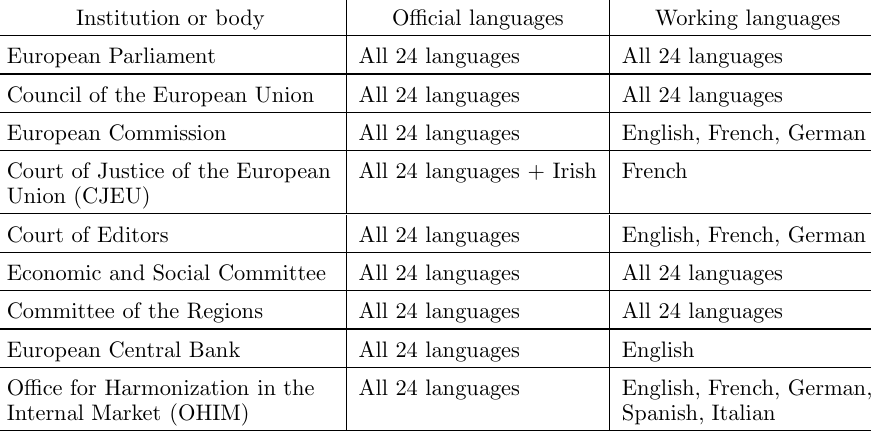
Official and working languages in the